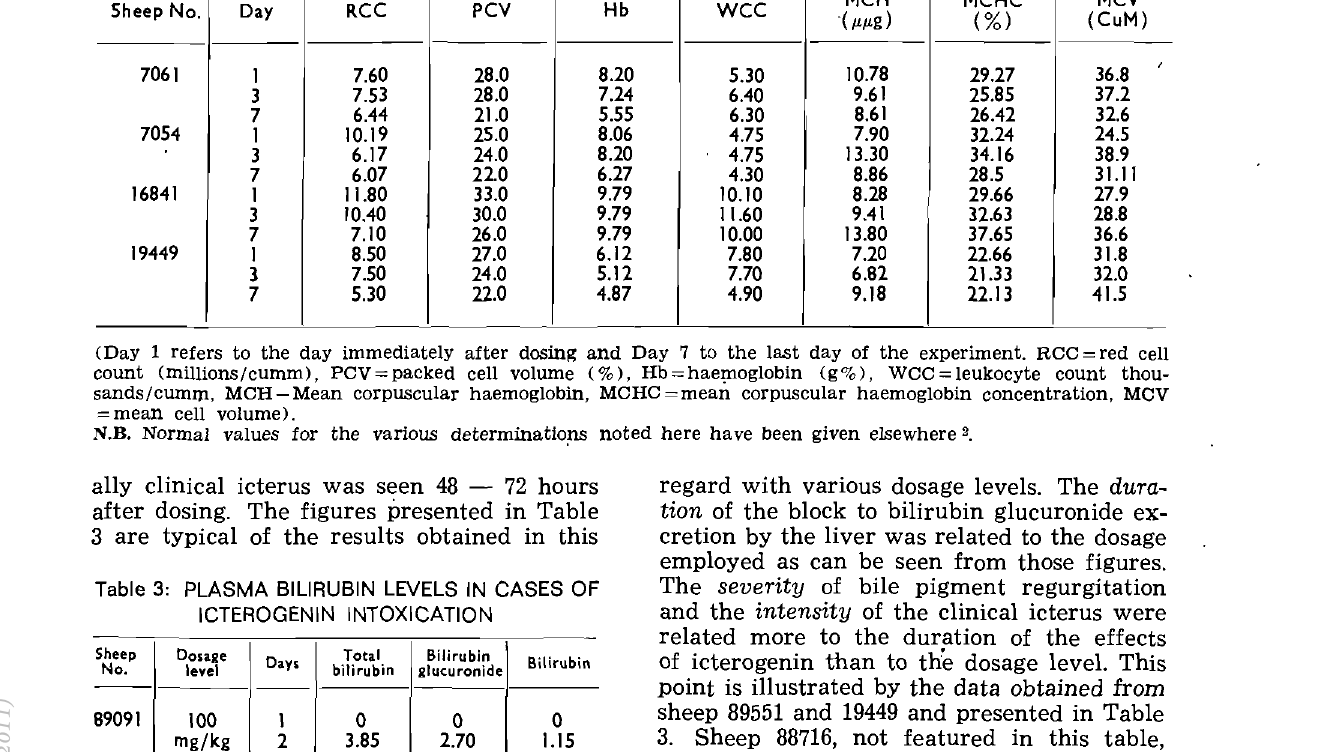
Table 2: HAEMATOLOGY OF THE ANIMALS THAT RECEIVED DOSES OF ICTEROGENIN HIGHER THAN 200 mg/kg 5heep No. Day RCC PCV Hb